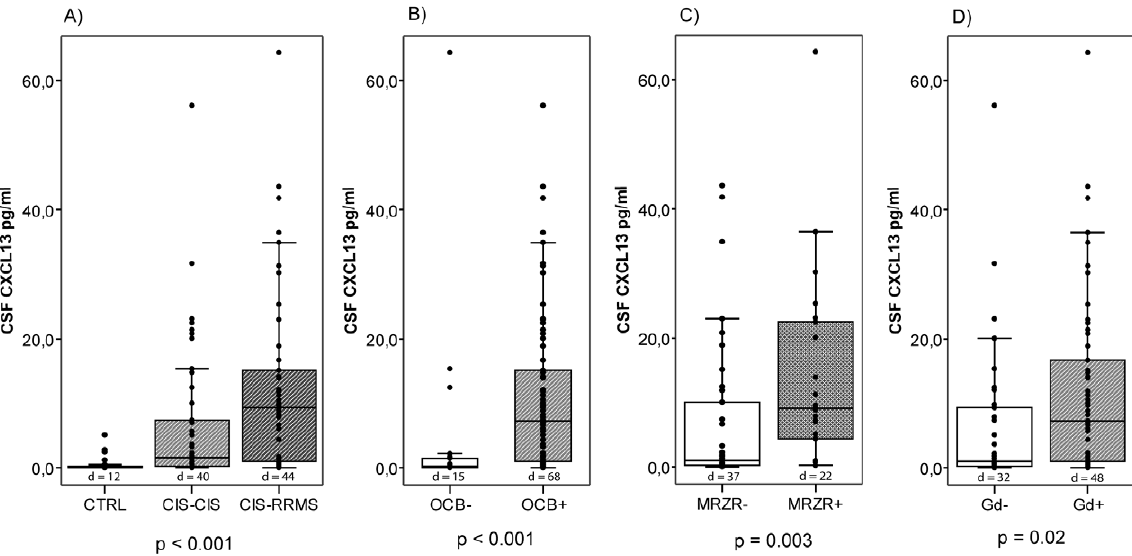
Figure 2. CXCL13 in patients with CIS. A) Boxplot shows CSF concentrations of CXCL13 in patients with CIS-CIS (patients with CIS that remained CIS over follow-up of two years), CIS-RRMS (CIS patients with conversion to MS over follow-up) and controls (CTRL). P-value refers to comparison of CIS-CIS, CIS-RRMS and controls. B) Boxplot shows CSF concentrations of CXCL13 in CIS patients with and without oligoclonal bands (OCB) in CSF. P- value refers to comparison of CIS patients with and without OCB. C) Boxplot shows CSF concentrations of CXCL13 in CIS patients with and without positive MRZR (‘‘MRZ reaction’’, intrathecal antibody production against measles, rubella and varicella zoster, with two antibody indices $ 1.5). P-value refers to comparison of CIS patients with and without MRZR. D) Boxplot shows CSF concentrations of CXCL13 in CIS patients with and without gadolinium-enhancing lesions in T1-weighted MRI. P-value refers to comparison of CIS patients with and without gadolinium-enhancing lesions. A)– D) The box represents the 25 th to 75 th quartile, the whiskers represent the range, and the horizontal line in the box represents the median. Black dots beyond the whiskers indicate outliers, d=number of patients with detectable CXCL13 concentrations in CSF.